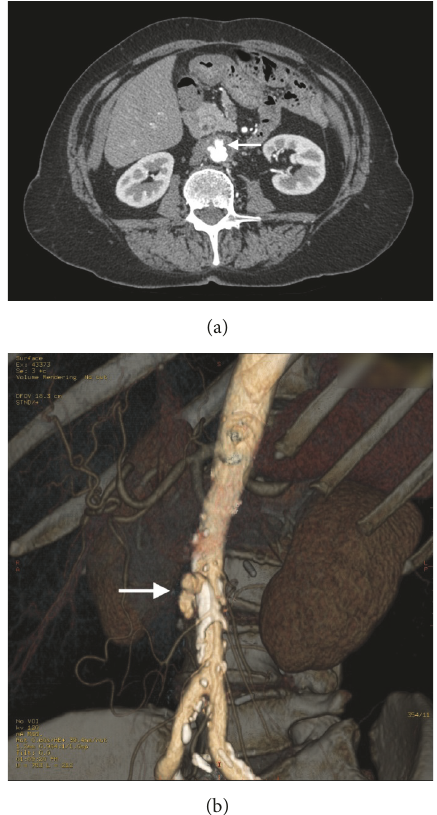
Figure 3: Axial (a) and reconstructed computed tomographic angiography (b) showing signs of prerupture.